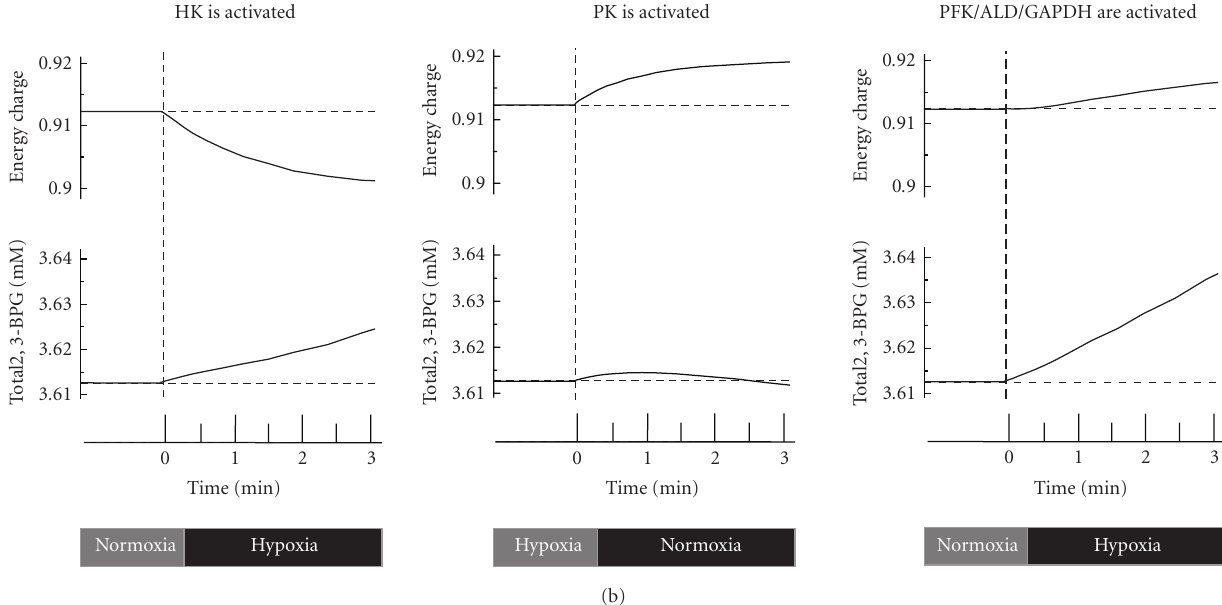
Figure 3: Temporal alterations in glycolysis in response to hypoxia. (a) Predicted alterations in glycolytic enzyme activities under hypoxia